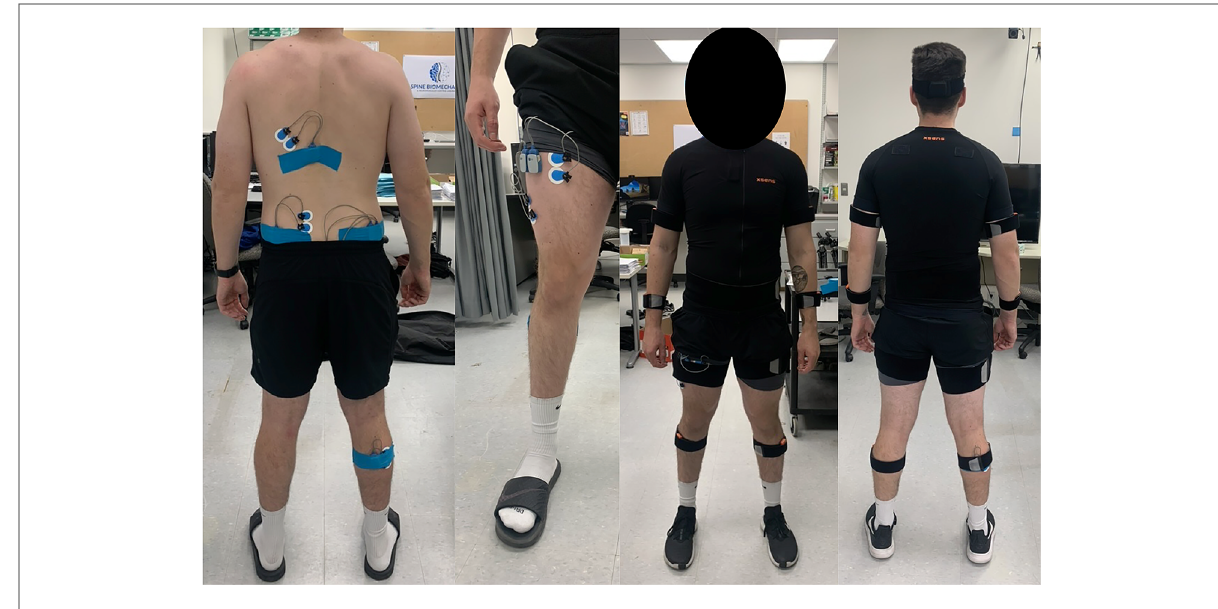
FIGURE 1 An example of the IMU and sEMG setup on the